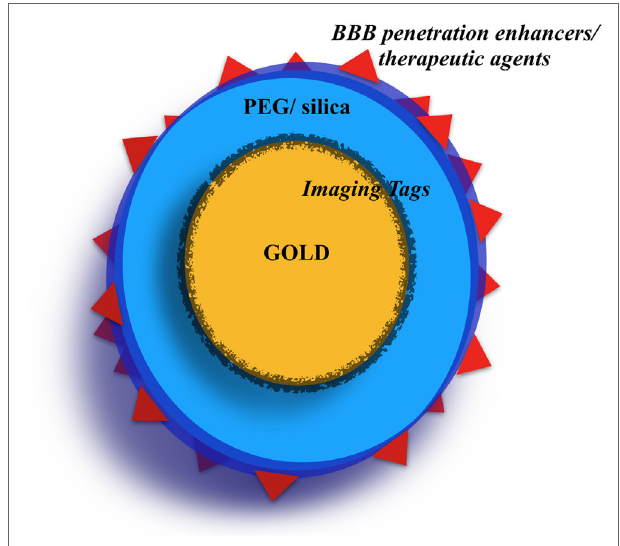
FiGURe 2 | The “typical” gold nanoparticle (GNP). The most used GNPs are the nanospheres. The gold core is sometimes covered with an imaging tag (i.e., Raman tags, fluorescent tag). Then, the GNPs are often covered by a polyethylene glycol (PEG) and/or silica shell. Finally, on the GNP surface, several molecules can be conjugated serving as blood-brain barrier (BBB) crossing internal enhancers or as chemotherapy